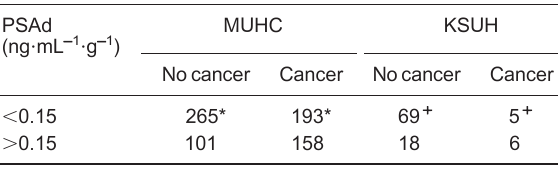
Data are reported as median values. See Table 1 legend for explanation of abbreviations. *P , 0.0001, + P=0.01 ( t